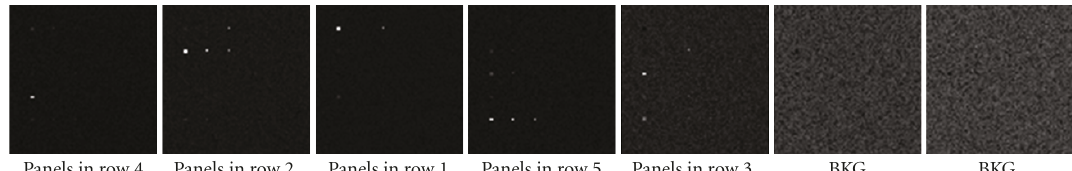
Figure 7: CEM detection results for TI.